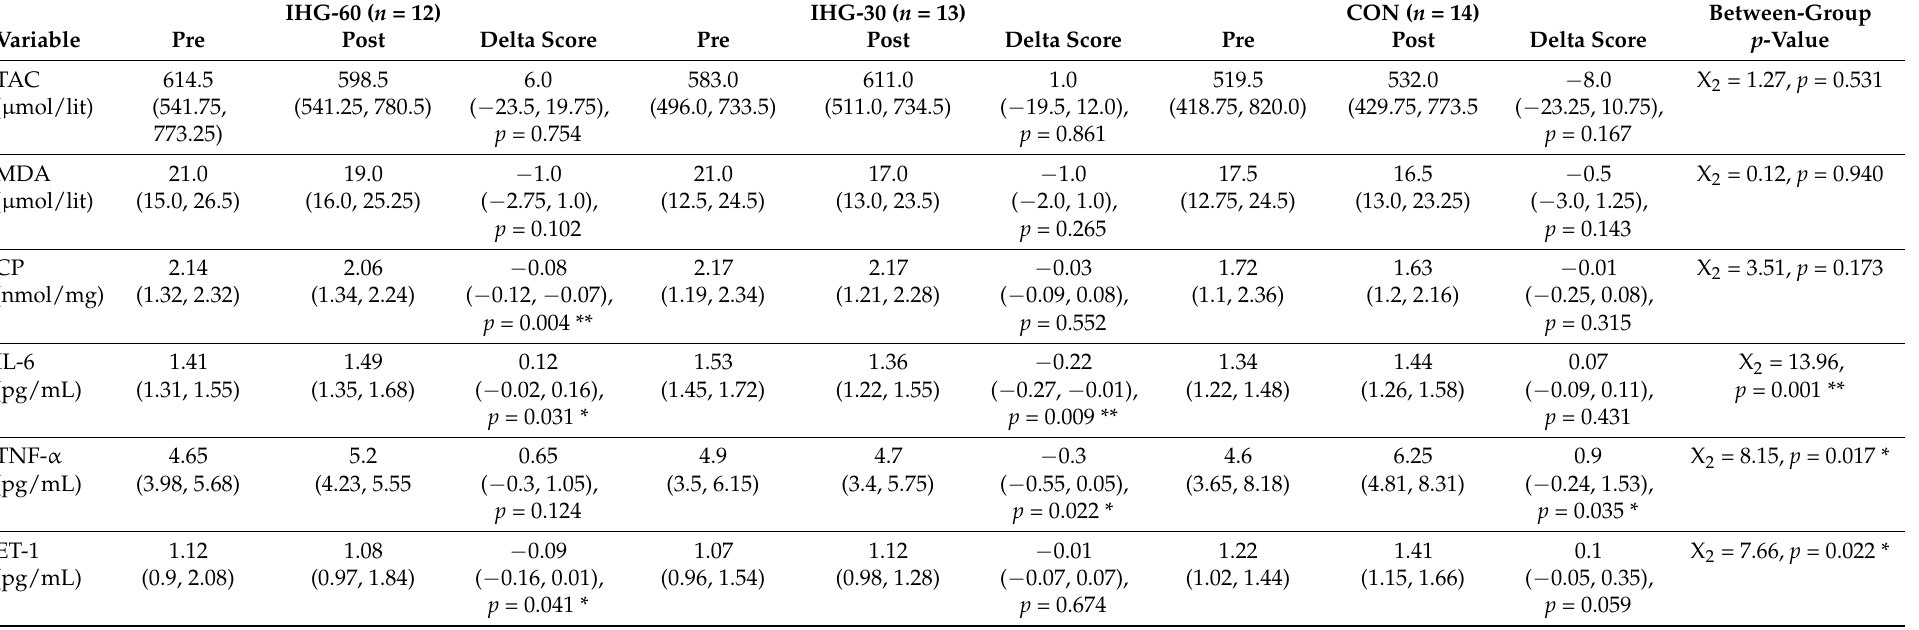
Table 2. Changes in serum markers of inflammation and oxidative stress within- and between